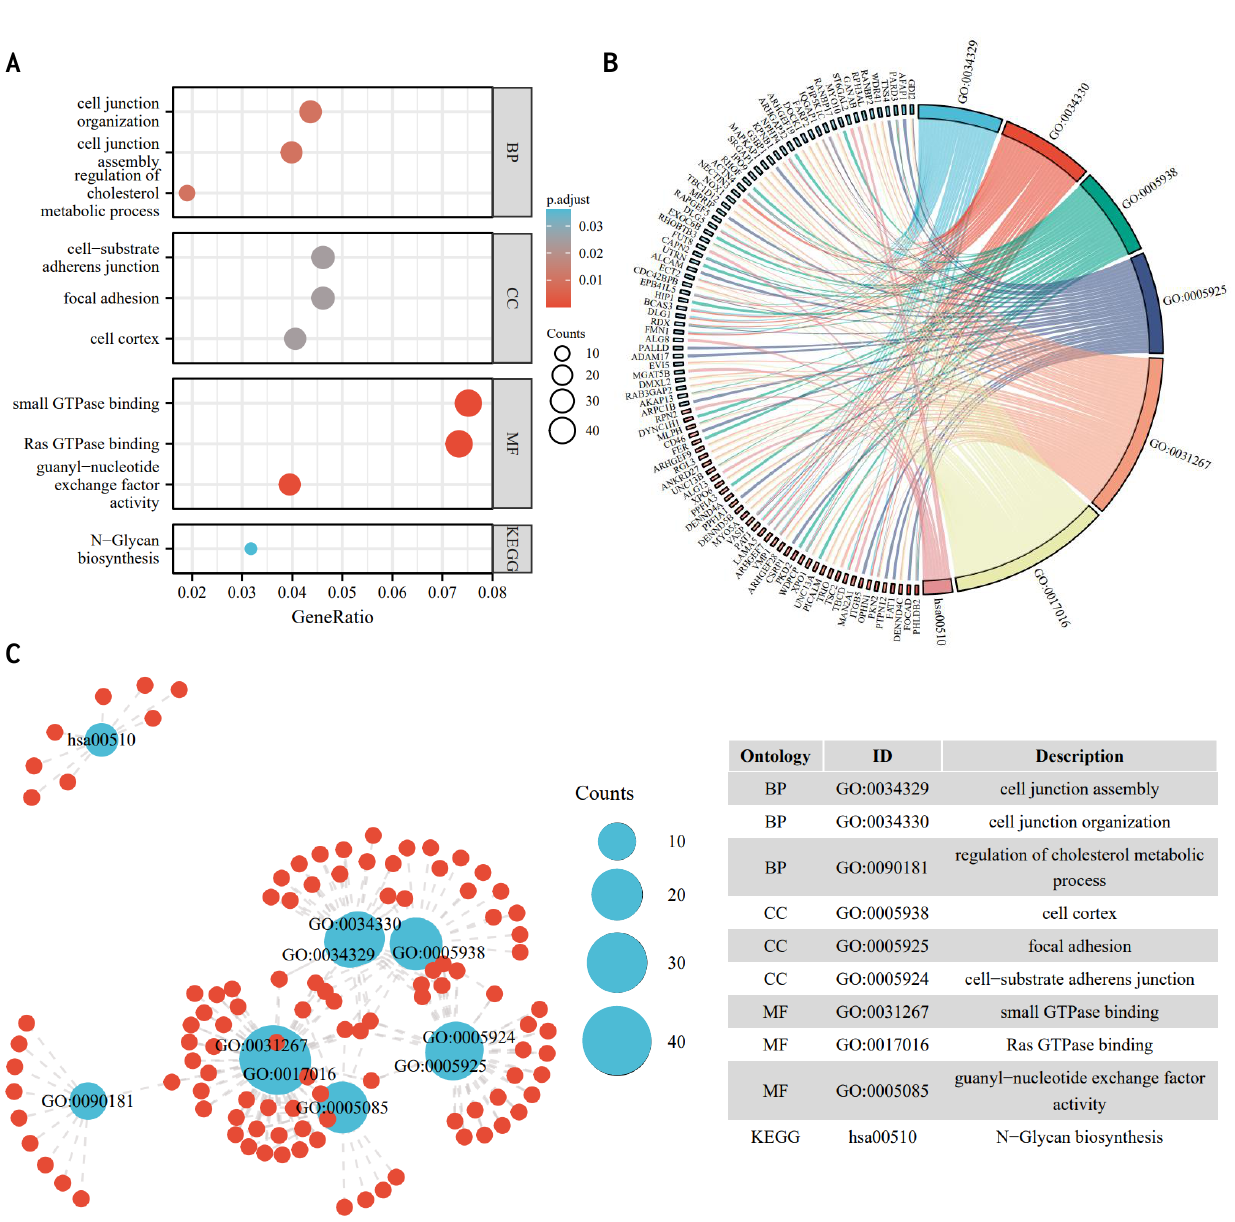
Figure 2. Gene ontology (GO) enrichment annotations and Kyoto Encyclopedia of Genes and Genomes (KEGG) analysis of DE-ncRNAs-related pathways. ( A ) Functional enrichment of DE- ncRNAs in the PD-treated A549 cells vs. the control. Top 3 enriched biological process (BP), cellu- lar component (CC), molecular function (MF), and the most enriched KEGG pathways are listed. ( B ) Chord diagram of DE-ncRNAs-associated genes and GO pathways. Significantly enriched GO pathways featured p values < 0.05. Each line represents a gene, and the number of lines indicates the genes enriched. ( C ) Enrichment map displays the enriched DE-ncRNAs-associated GO and KEGG pathways in the PD-treated A549 cells vs. the control. Blue nodes represent items and the red nodes represent molecules. Node size represents the gene-set size and the dot lines represent the connection between the corresponding items and the